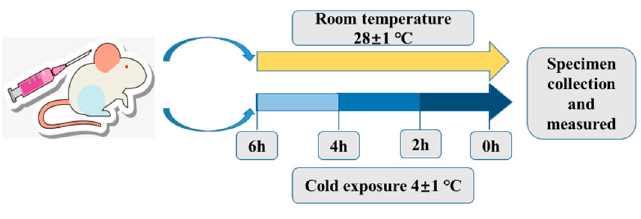
Figure 11. Study Protocol. Mice in the room temperature (RT) control group were left undisturbed, whereas cold-exposed mice were exposed to 4 °C.